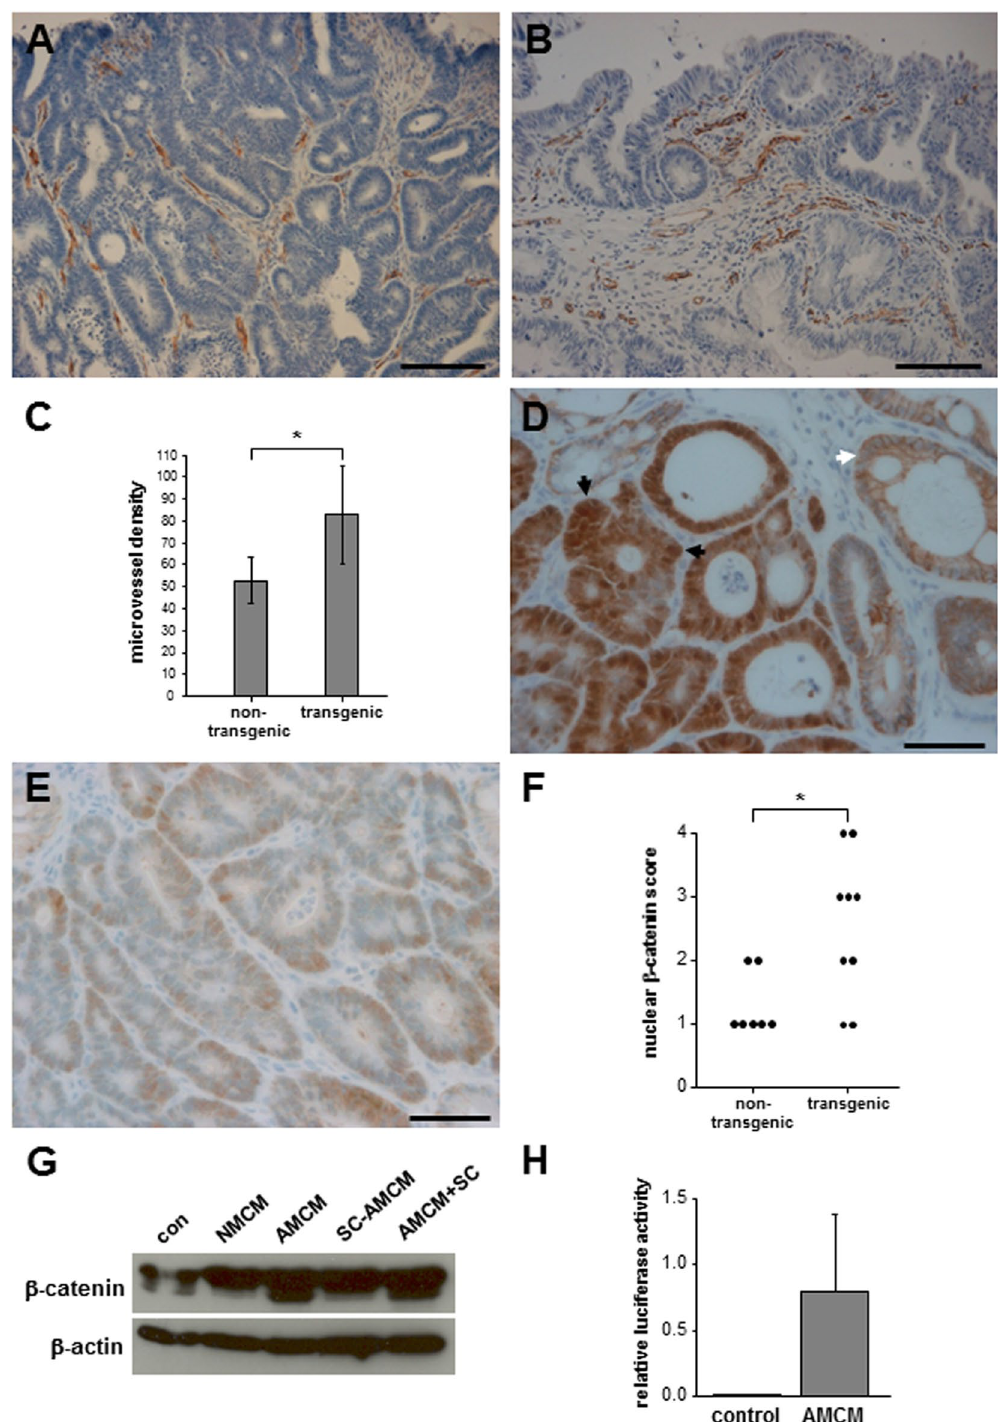
Figure 5. Transgenic cLys-Cox-2 x Apc Min/ + mouse colonic tumours have increased tumour-associated angiogenesis and nuclear β -catenin localisation in dysplastic epithelial cells. ( A ) Immunohistochemistry for mouse CD31 demonstrating capillary microvessels in a non-transgenic Apc Min/ + mouse colonic tumour. Size bar = 50 μ m. ( B ) CD31-positive endothelial cells in microvessels in a transgenic cLys-Cox-2 x Apc Min/ + mouse colonic tumour. Size bar = 50 μ m. ( C ) Microvessel density (number of CD31-positive foci per ‘hotspot’ 100 x microscopic field) in Apc Min/ + mouse colonic tumours. Bars represent the mean and SEM of the MVD for non-transgenic Apc Min/ + mouse tumours (n = 8) and transgenic cLys-Cox-2 x Apc Min/ + mouse tumours (n = 6). * P = 0.25; Student’s t test). ( D ) Immunohistochemistry for β -catenin on a transgenic cLys-Cox-2 x Apc Min/ + mouse colonic tumour demonstrating strong nuclear and cytoplasmic β -catenin immunoreactivity (score 4) in dysplastic epithelial cells (black arrows) compared with the membranous distribution of β -catenin and absence of nuclear staining in neighbouring non-neoplastic epithelium (white arrow). Size bar = 50 μ m. ( E